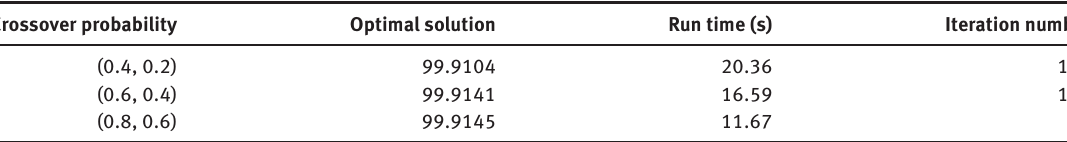
Table 4. Comparison of Running Results of Different Crossover Probability.